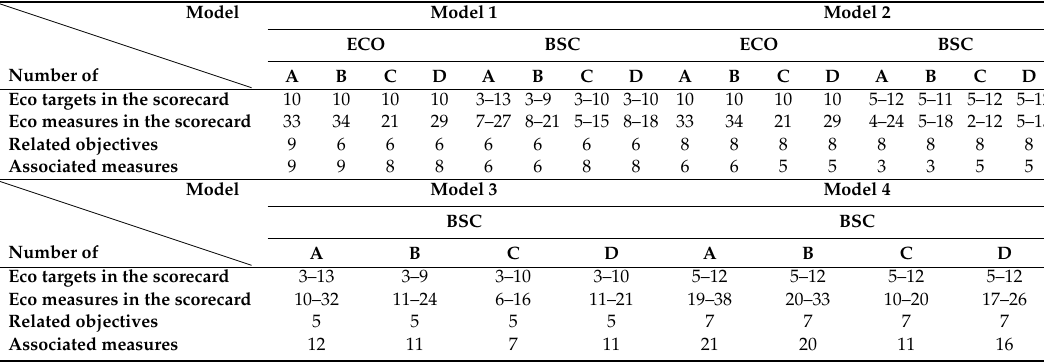
Table 4. Numbers of targets, measures and objectives in the 4 recommended BSC